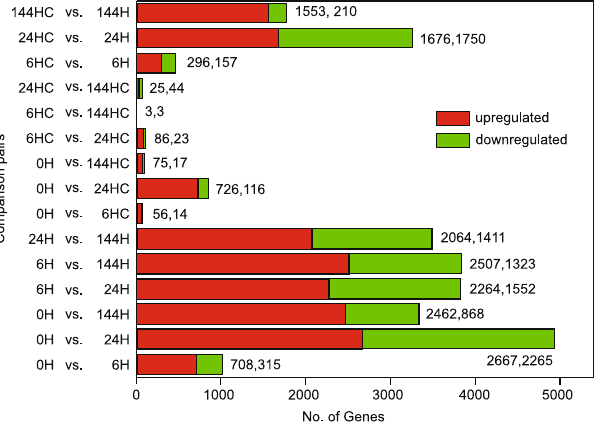
Figure 2. Comparison of the differential expressed genes of each pairs. The labels of the samples are displayed as “hours after bag-removal” (H) or “hours without bag-removal” (HC) Note that bag removal significantly changes the gene expression pattern in the fruit peel, while genes of the control had an expression pattern similar to the 0 h Validation of DEGs identified using RNA-Seq.